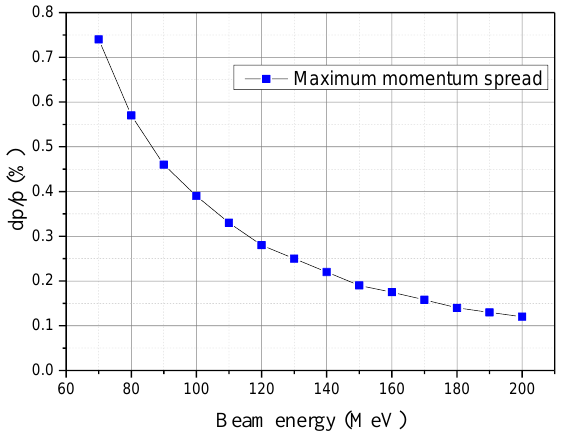
Figure 4. The maximum allowed momentum spread under different energies.